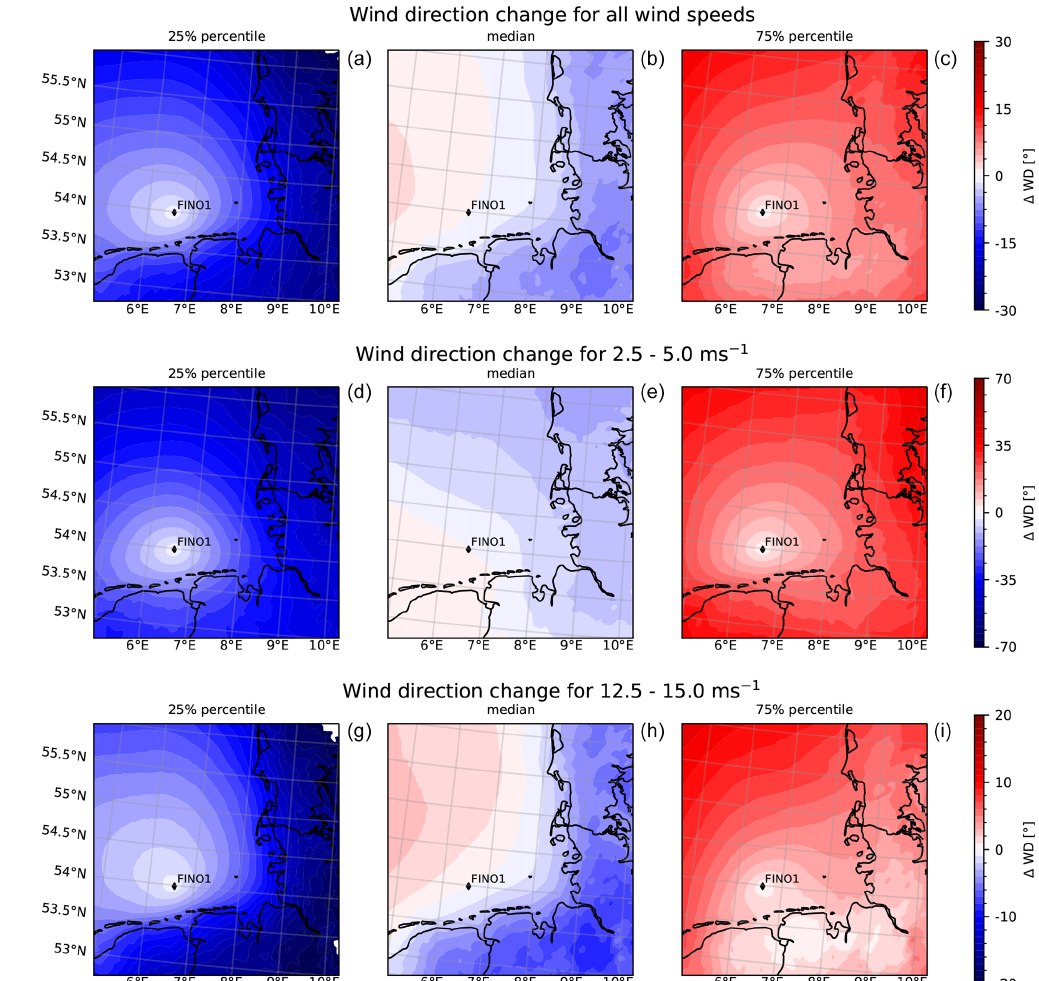
Figure 5. Statistics of local wind direction changes with respect to FINO1 for the 30 years of NEWA data and different wind speed ranges. Panels (a, d, g) and (c, f, i) show the lower and upper quartiles, respectively. Panels (b, e, h) show the median for all wind speeds (b) and the wind speed ranges of 2.5–5.0ms − 1 (e) and 12.5–15.0ms − 1 (h) . Note the different color scales for the wind speed ranges. The coastline and border data originate from the Natural Earth dataset (Natural Earth,